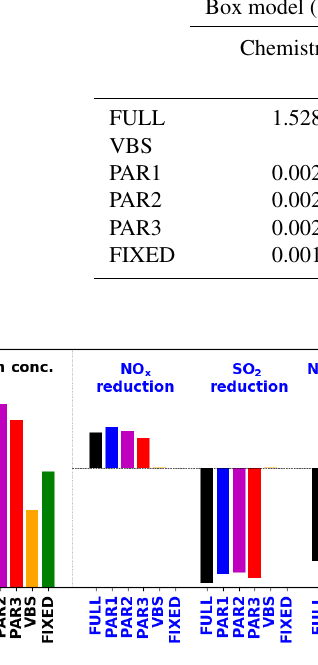
Figure 6. Global PBL averaged IEPOX-SOA concentrations (left, black) and the concentration changes with anthropogenic emission reductions (right, blue) for July–August 2013. The anthropogenic emissions were decreased by 50% for each sensitivity